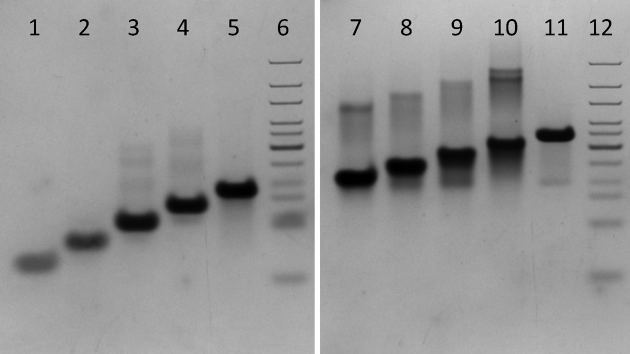
Room temperature native PAGE of the model ODNs (10 μM in 10 mM sodium cacodylate at pH 7.4) with increasing tract lengths at pH 7.4. Acrylamide gels (20%) were buffered with 50 mM tris, 50 mM HEPES at pH 7.4. ODNs were annealed at pH 7.4 as described above. The samples were loaded onto the gel for electrophoresis at 50 V for 5 h. Lane contents left to right are as follows: (1) C1T3; (2) C2T3; (3) C3T3; (4) C4T3; (5) C5T3; (6) Base pair ladder standard; (7) C6T3; (8) C7T3; (9) C8T3; (10) C9T3; (11) C10T3; (12) Base pair ladder standard.